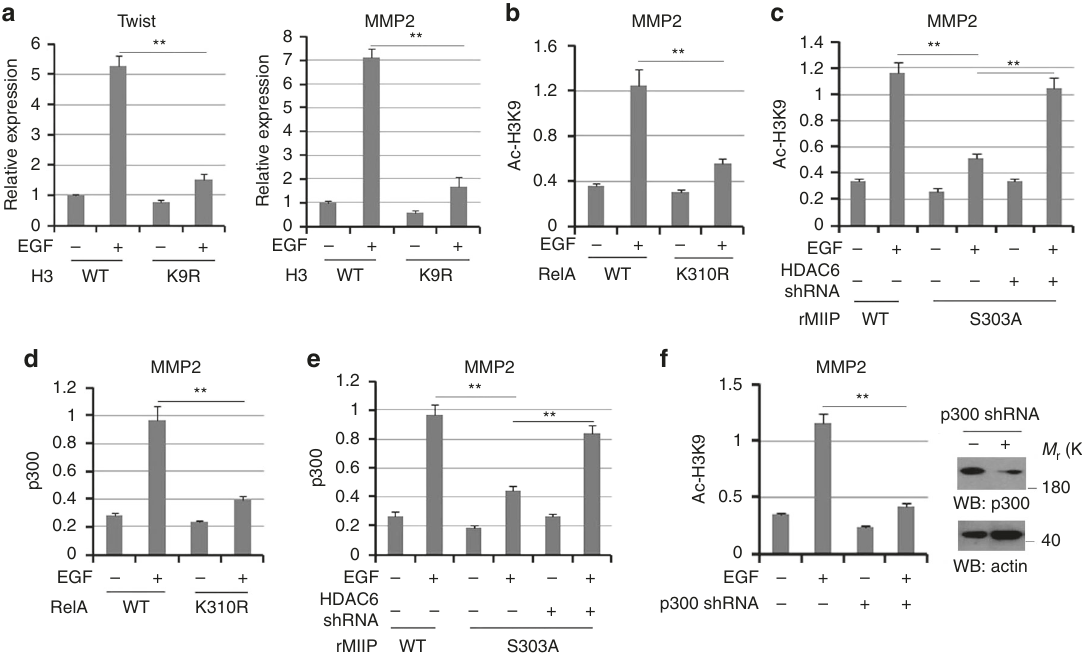
Fig. 5 MIIP – RelA facilitates H3-K9 acetylation at promoter region. a HCT116 cells expressed with WT H3 or H3 K9R were treated with or without EGF (100 ng/ml) for 10 h. Relative mRNA levels were analyzed by q-PCR. b , d HCT116 cells expressed with WT RelA or RelA K310R were treated with or without EGF for 10 h (100 ng/ml). c , e HCT116 cells expressed with WT MIIP or MIIP S303A were overexpressed with or without HDAC6; cells were treated with or without EGF (100 ng/ml) for 10 h. f HCT116 cells transfected with or without plasmid for expressing p300 shRNA were treated with or without EGF (100 ng/ml) for 10 h. In b – f , ChIP analyses with indicated antibodies were performed. The primers covering RelA binding site of MMP2 gene promoter region were used for the q-PCR. The Y axis shows the value normalized to the input. In a – f , the values are presented as mean ± s.e.m. ( n = 3 independent experiments), ** represents P < 0.01 (Student ’ s t -test) between the indicated (Supplementary Fig. 4d) or RelA Ac-K310 in CaCo2 cells (Supplementary Fig. 4e), inhibited transcription of MMP2 and Twist (Supplementary Fig. 4f) and tumor cell invasion (Supple- mentary Fig. 4g). Meanwhile, EGF stimulation also led to the trimmer complex formation of RelA – MIIP – HDAC6 in CaCo2 cells (Supplementary Fig. 4h).